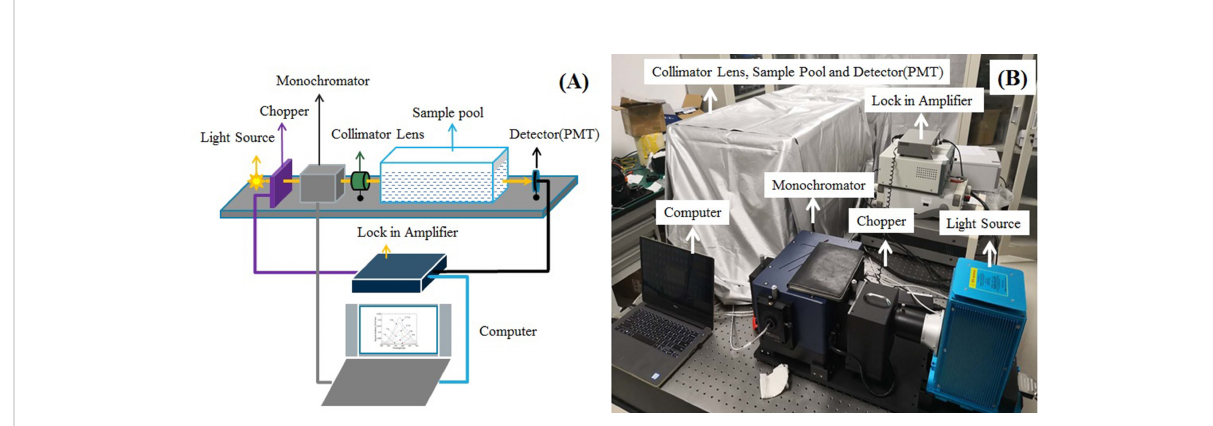
FIGURE 1 The experimental setup of light attenuation analysis: (A) the schematic diagram of experimental setup; (B) the photo of experimental setup.